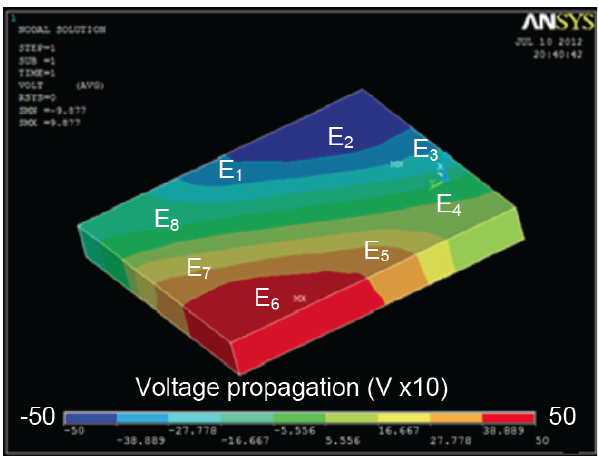
Figure 13. Voltage distribution in the case of 8-electrode architecture using ANSYS. Voltage distribution is multiplied by 10 in ANSYS due to simulation constraints.